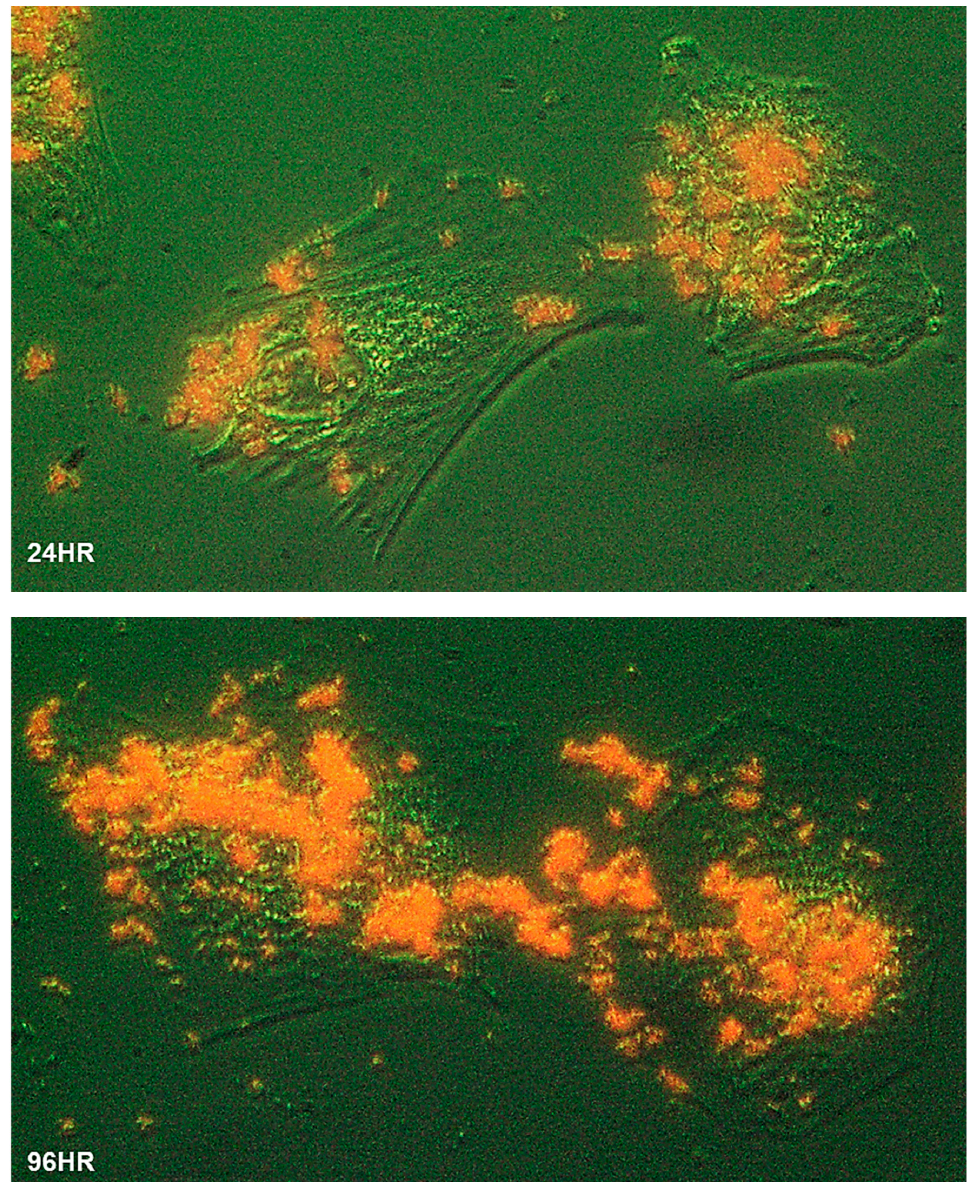
Figure 2. Biomineralization of human cells. The Saos-2 cells grew at low confluency on a glass slide immersed in MEM α / 10% FBS with α GP (2 mM) for 24 h (24HR) and 96 h (96HR), respectively. The slides were washed, fixed, and stained with Alizarin Red S. The cell morphology was illustrated using optical phase-contrast (with pseudo-green background), and HAP minerals were in red under a ZEISS inverted microscope equipped with an Infinity 3 digital camera and imaging software. Cells were magnified 400×.